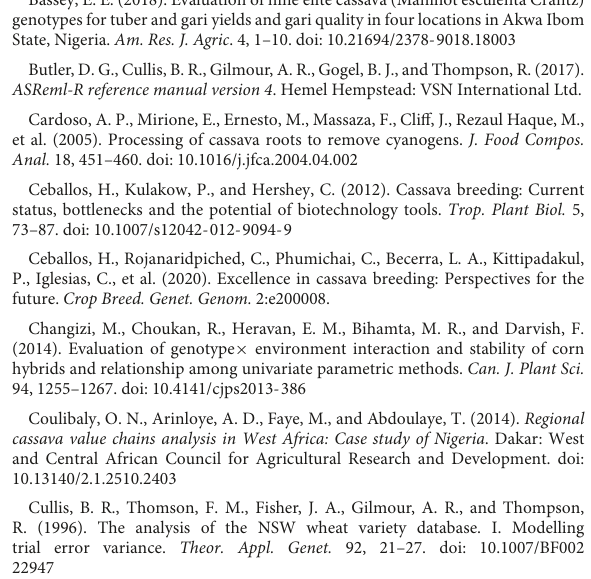
SUPPLEMENTARYFIGURE2 Vector views of PC2 are plotted against PC1 Gari_yield. SUPPLEMENTARYFIGURE3 Vector views of PC2 are plotted against PC1 Harvest_index. SUPPLEMENTARYFIGURE4 Vector views of PC2 are plotted against PC1 Root size. SUPPLEMENTARYFIGURE5 Vector views of PC2 are plotted against PC1 Root number. SUPPLEMENTARYFIGURE6 Vector views of PC2 are plotted against PC1 Dry root yield. SUPPLEMENTARYFIGURE7 Vector views of PC2 are plotted against PC1 Fresh root yield. SUPPLEMENTARYFIGURE8 Vector views of PC2 are plotted against PC1 Fiber content. SUPPLEMENTARYFIGURE9 Vector views of PC2 are plotted against PC1 Peel loss. SUPPLEMENTARYFIGURE10 Vector views of PC2 are plotted against PC1 Dry matter